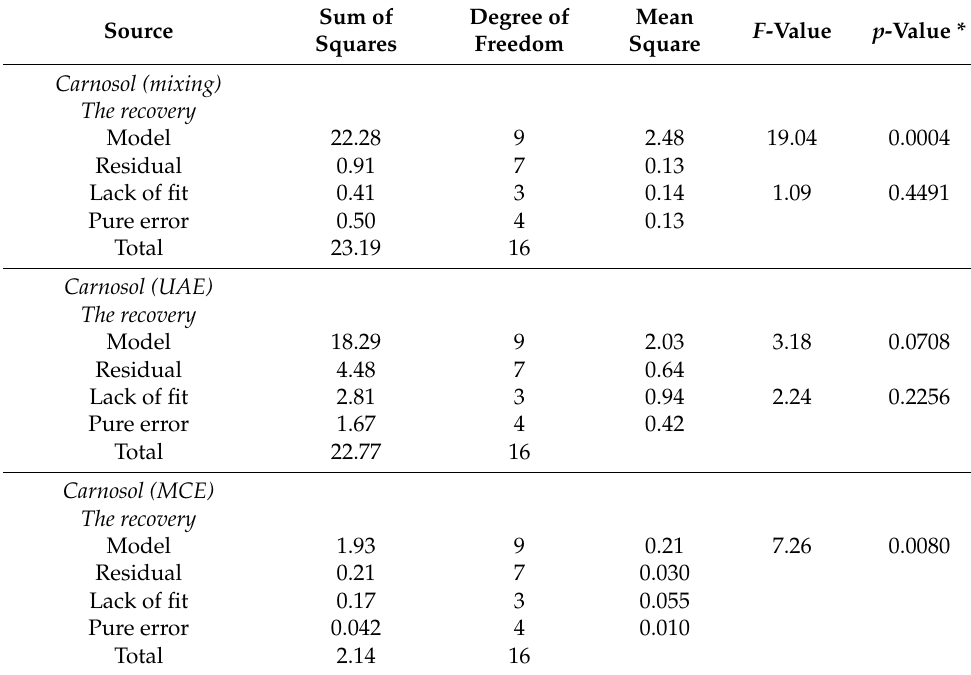
Sum of Degree of Mean F -Value p -Value * Squares Freedom Square